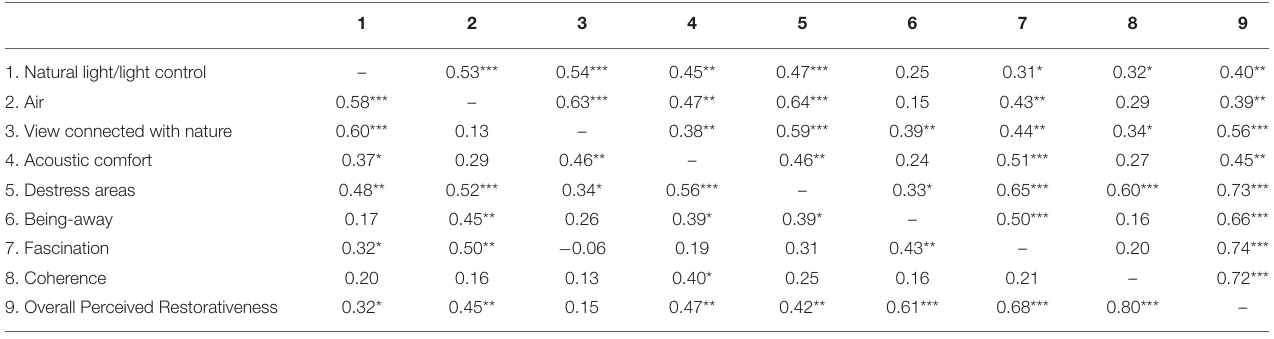
TABLE 2 | Pearson’s correlation coefficients between the study variables about quality and restorativeness of the workplace (T1 assessment below the diagonal, N1 = 39, and T2 assessment above the diagonal, N2 = 48). 1 2